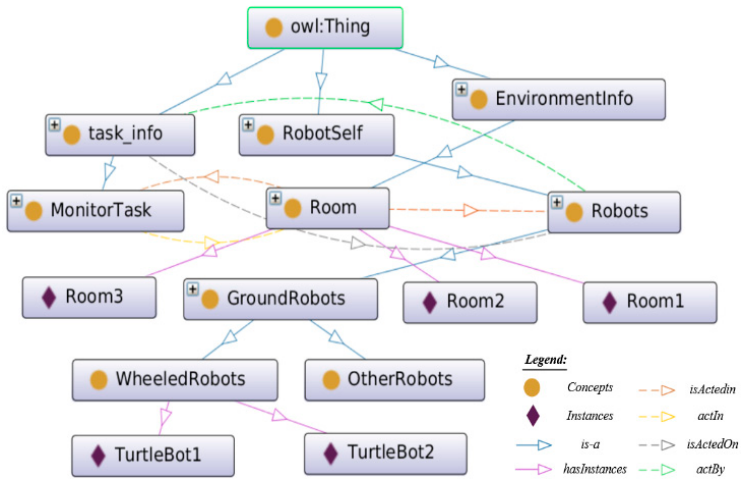
Figure 10. The communications among three parts in Protégé.